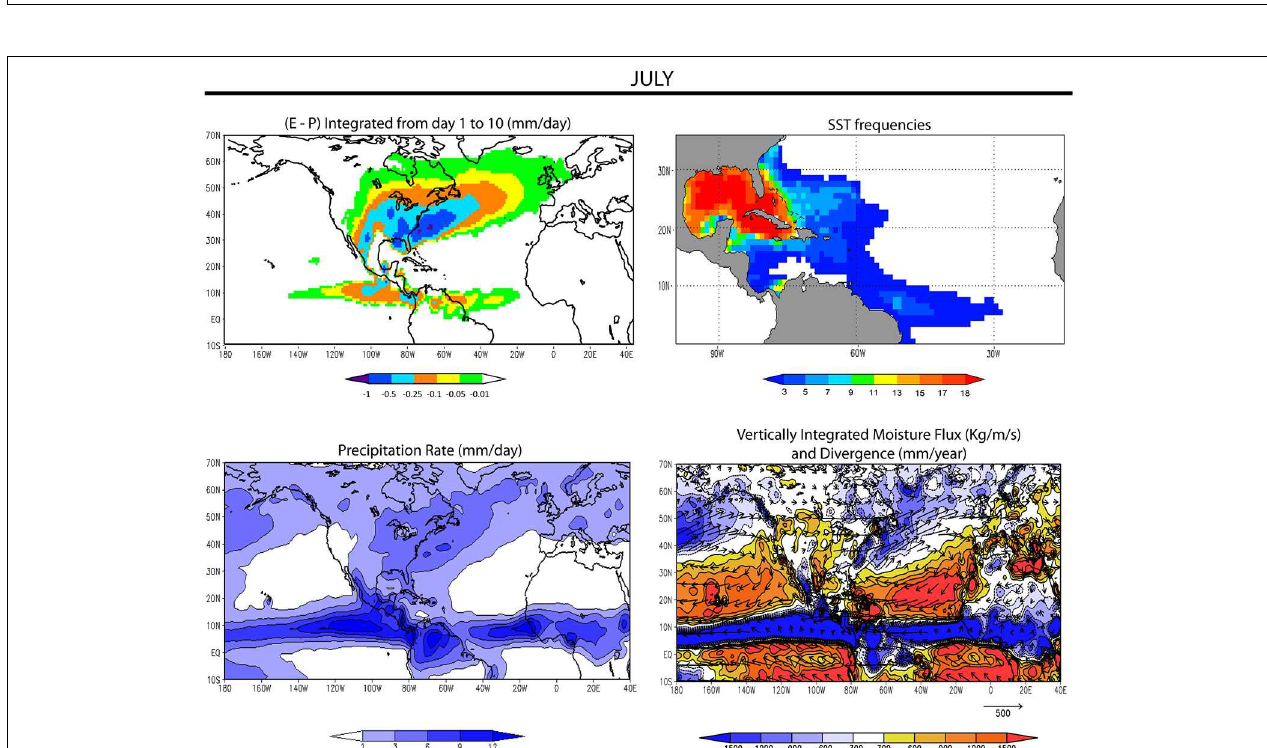
FIGURE 3 | As Figure 1, for